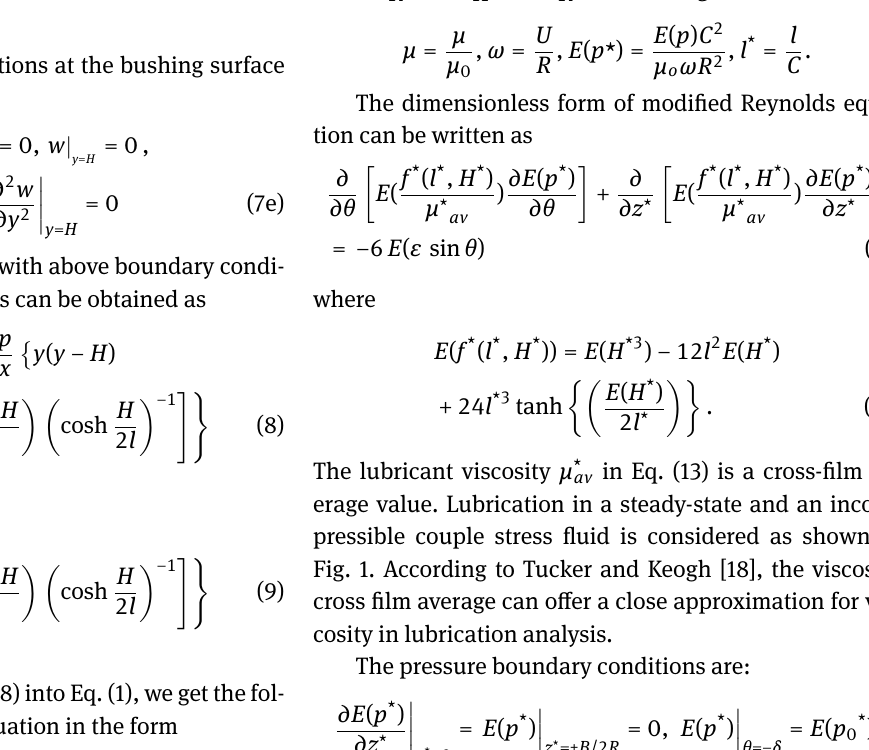
Fig. 1: The schematic diagram of journal bearing